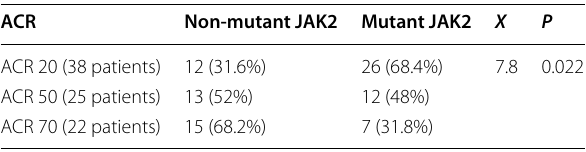
Table 3 ACR composite measure of mutant, non‑mutant JAK2 RA patients